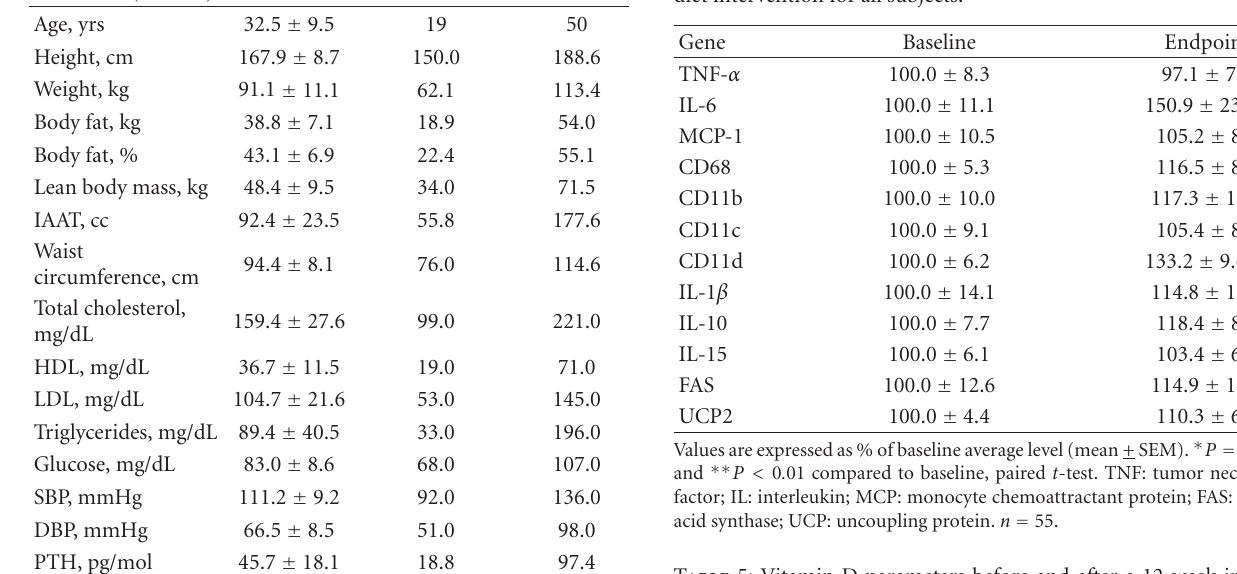
Table 5: Vitamin D parameters before and after a 12-week inter- vention of low-dairy (LD) or adequate dairy (AD) diets.